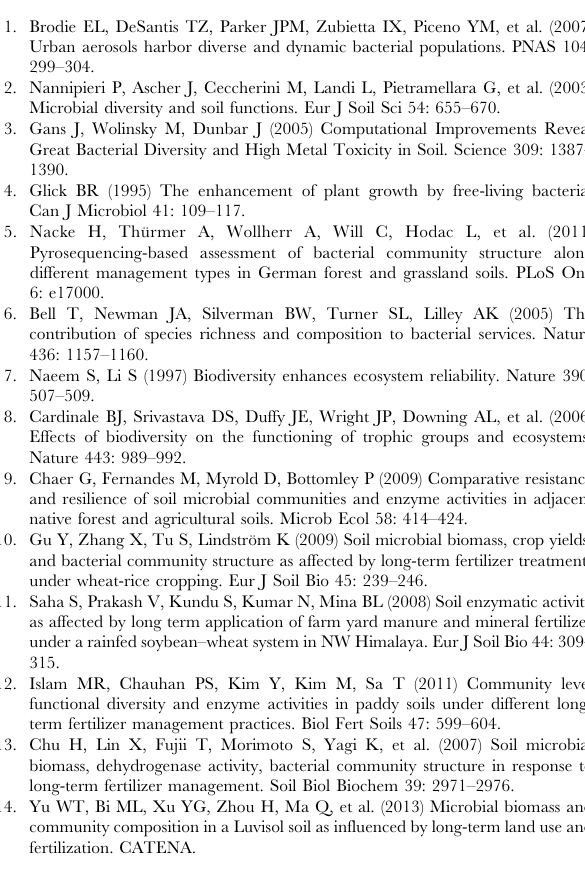
Table S3 Relative average abundances of phyla across all soils and soils grouped into fertilizer regime and sampling time categories, respectively (values represent % of total non-redundant sequences). Asterisks mean values less than 0.01. Table S4 Effects of fertilizer regime, sample time and the interaction between them on the abundant phyla (relative abundance . 1%). Table S5 Effects of fertilizer regime, sample time and the interaction between them on the OTUs, coverage, richness and diversity calculated using a random 4,000 sequences per